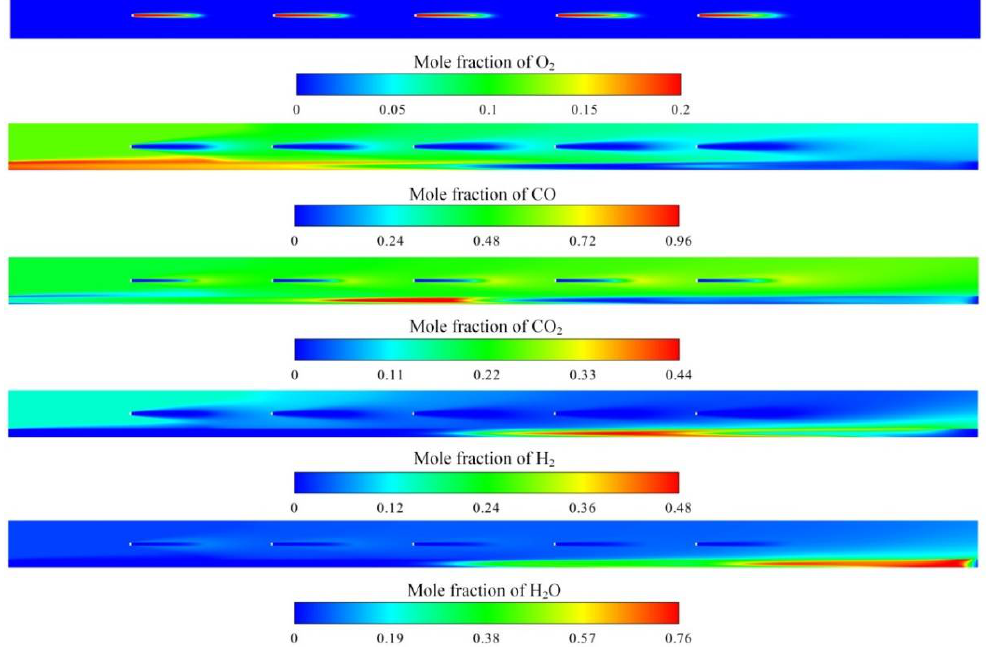
Figure 8. Composition distributions of the gas phase along the axial section.